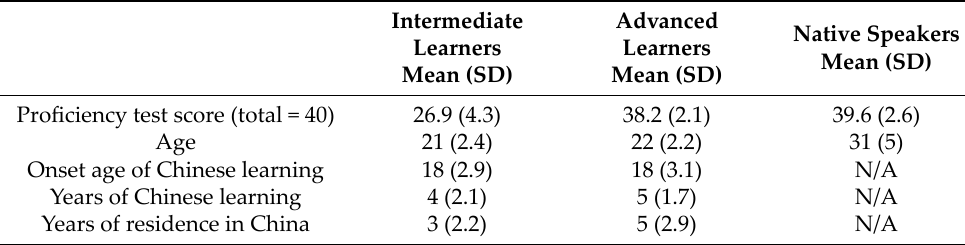
Table 1. Background information of